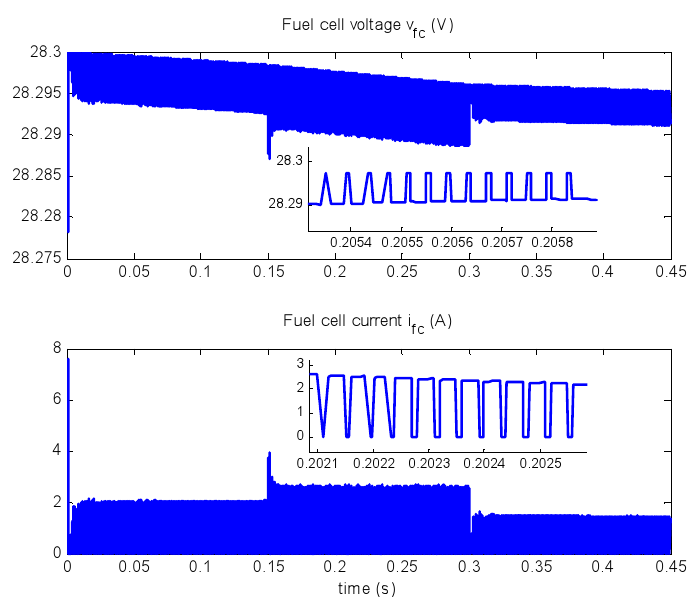
Figure 10. Fuel cell voltage and current in the presence of a time-varying reference.